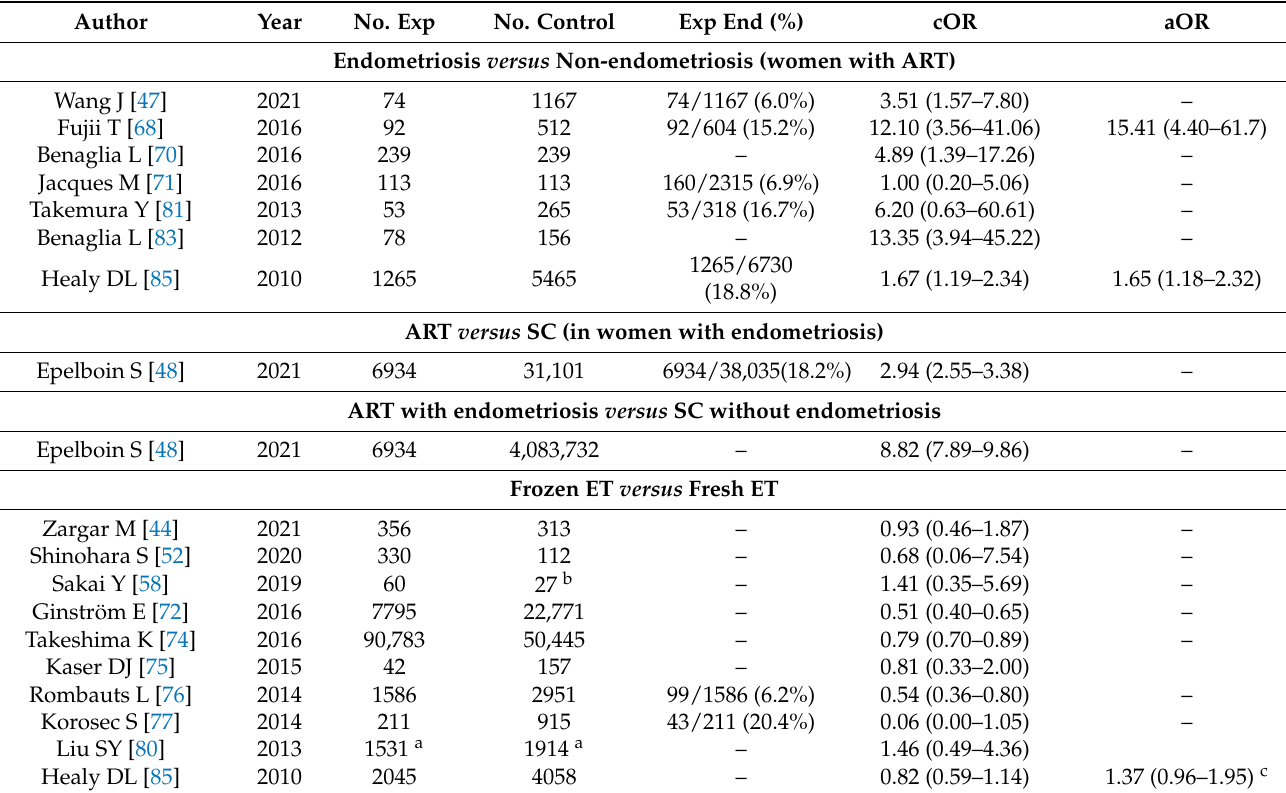
Table 4. Rates of placenta previa for women who conceived using ART (sensitivity